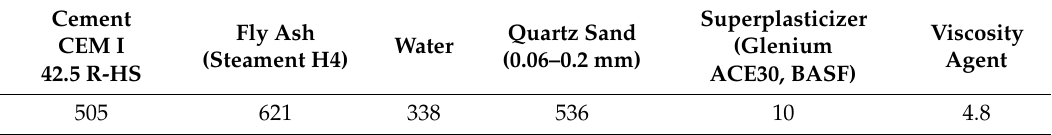
Table 1. The composition of the matrix (kg / m 3 ).